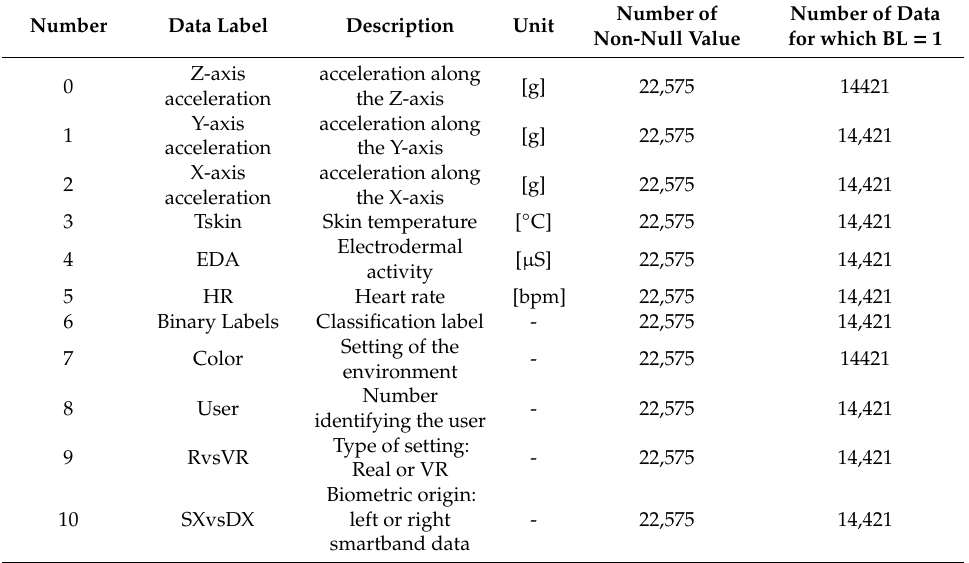
Table 4. Dataset attributes. VR: Virtual Reality.